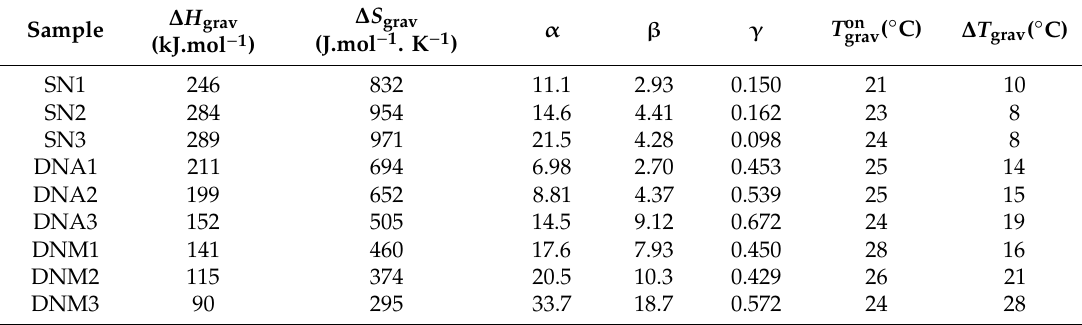
Table 2. Transition parameters of hydrogels determined during heating by gravimetric